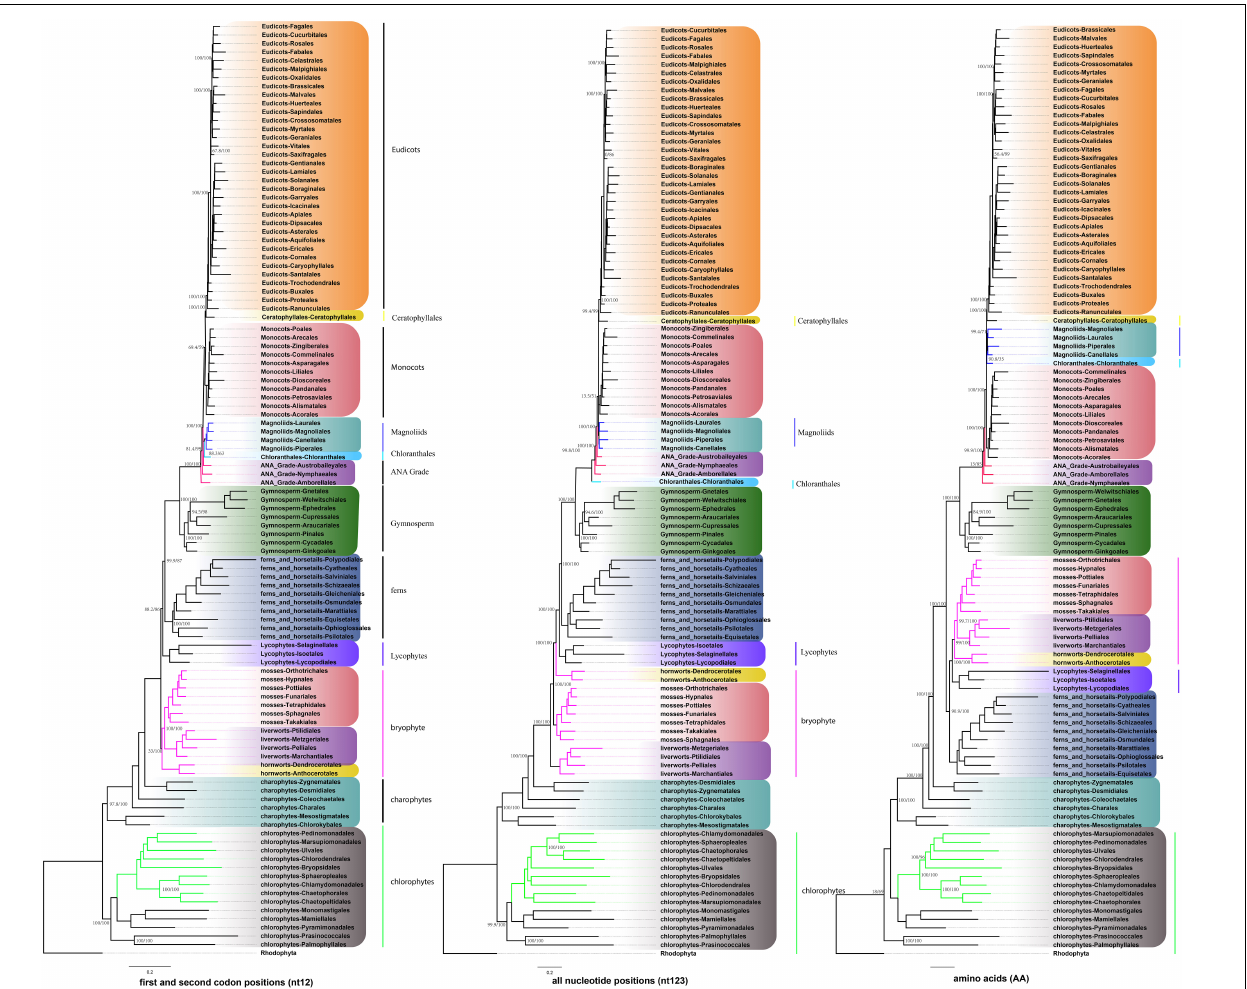
FIGURE 4 | Summary of the phylogenomic tree based on three data sets (nt12, nt123, and AA) of 72 plastid protein-coding genes of 3,654 green plants and six Rhodophyta using IQTREE. The colored branch and vertical lines (on the right side of the tree) represent the clade with conflicting phylogenetic placements based on three data sets. Totally, 631 taxa were obtained by selecting one to three representatives from each family and at least one taxon for the families with fewer taxon sampling, and the tree is represented at the order level in the